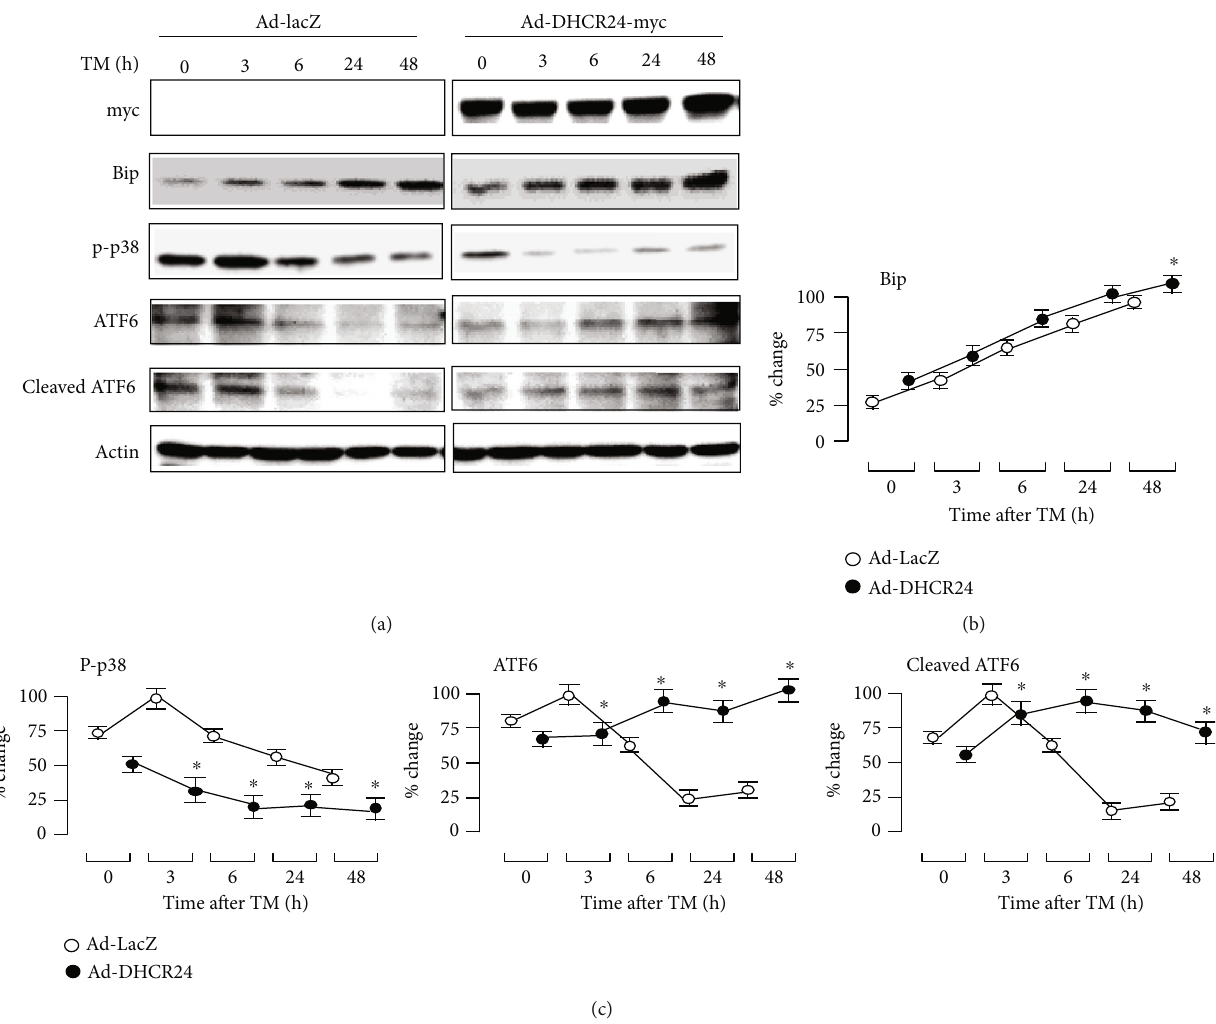
Figure 3: UPR-related signaling pathways were detected after TM treatment by Western blot analysis. (a) Representative Western blots show the expression of c-myc, Bip, p-p38, ATF6, and cleaved ATF6 in MIN6 cells after TM treatment. The levels of these proteins were normalized to actin levels. (b, c) The levels of Bip, p-p38, ATF6, and cleaved ATF6 were calculated as percentage of the largest level in the negative control (Ad-LacZ) group. Mean ± S : D : ( n = 3 ); ∗ p < 0 : 05 vs.